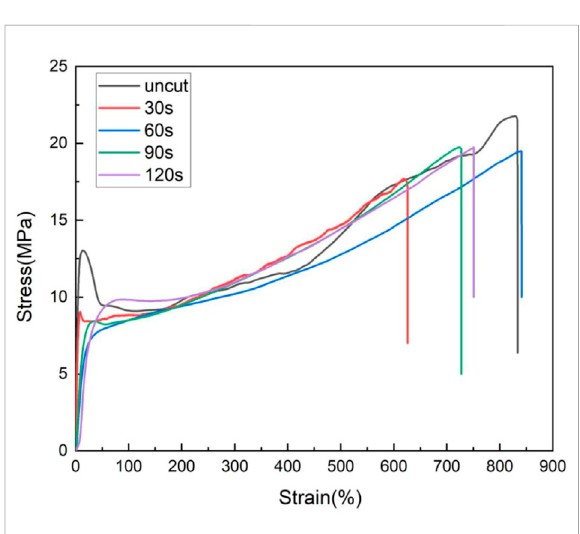
FIGURE 10 The stress-strain curves of PCU/PPy-x after self-healing.